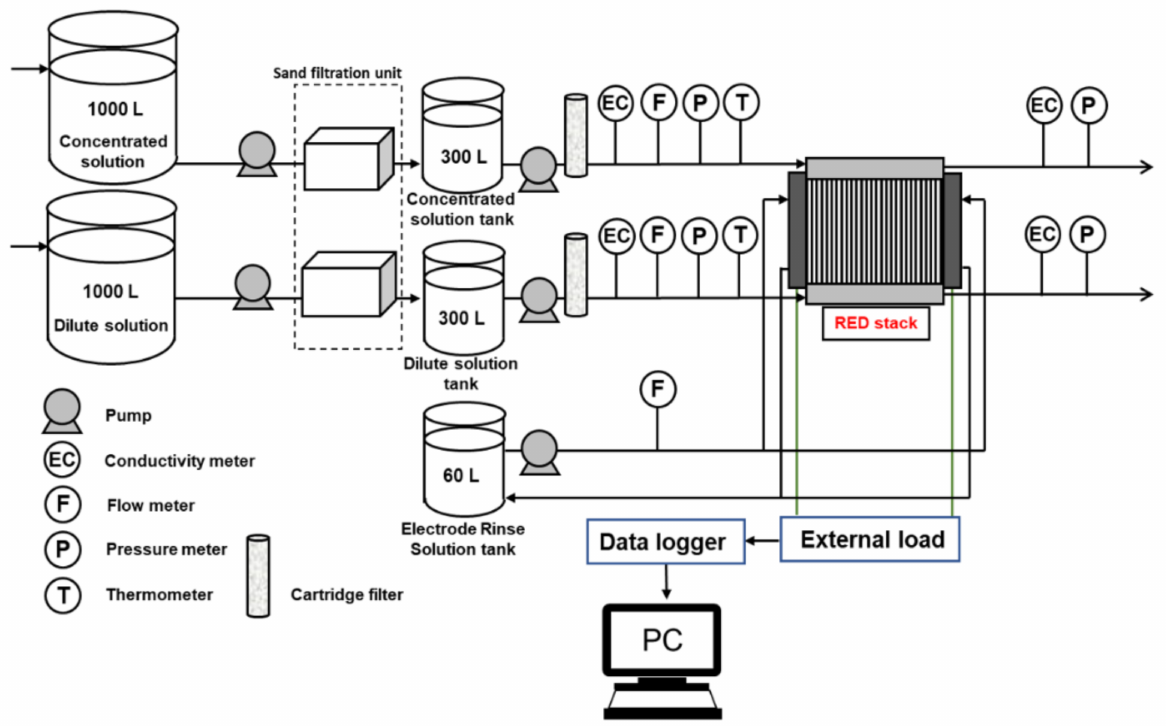
Figure 2. Reverse electrodialysis (RED) plant layout includes RED stack, pre-treatment system, and pumping